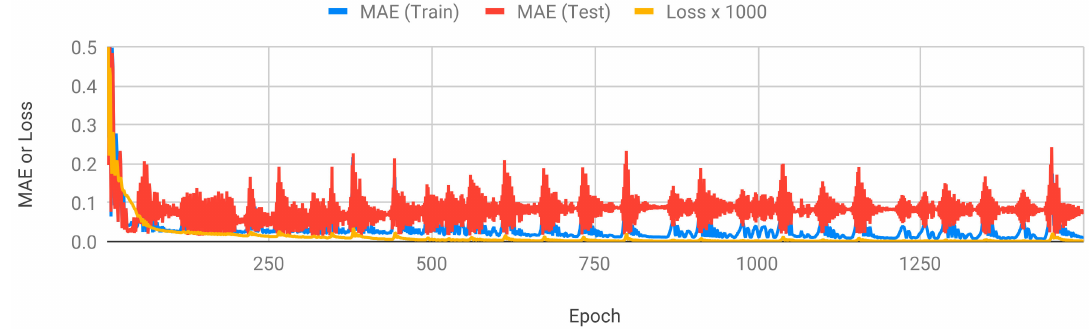
Figure 5. MAE and Loss of